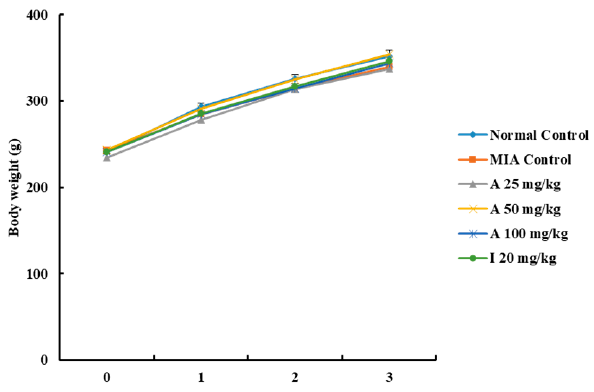
Figure 6. Effects of AyuFlex ® on changes in body weight of rats with monosodium iodoacetate (MIA)-incurred osteoarthritis (OA). Body weight was evaluated once a week for three weeks and the data are presented as the mean ± SEM ( n = 8 / group). A, AyuFlex ® ; I, Ibuprofen. No significant difference was discovered between any of the groups.